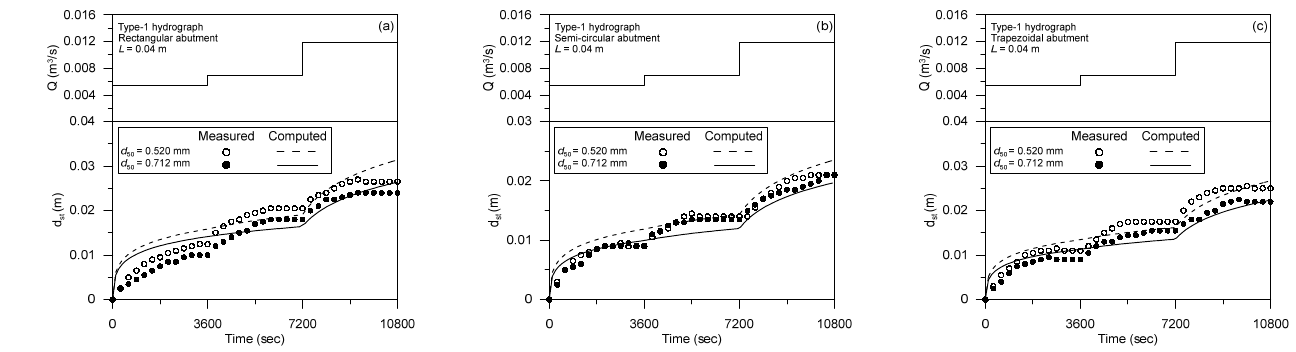
Figure 9. Comparison of computed and measured abutment-scour evolution under Type-I stepwise (advanced) hydrograph. ( a ) Rectangular abutment ( b ) Semicircular abutment ( c ) Trapezoidal abutment.